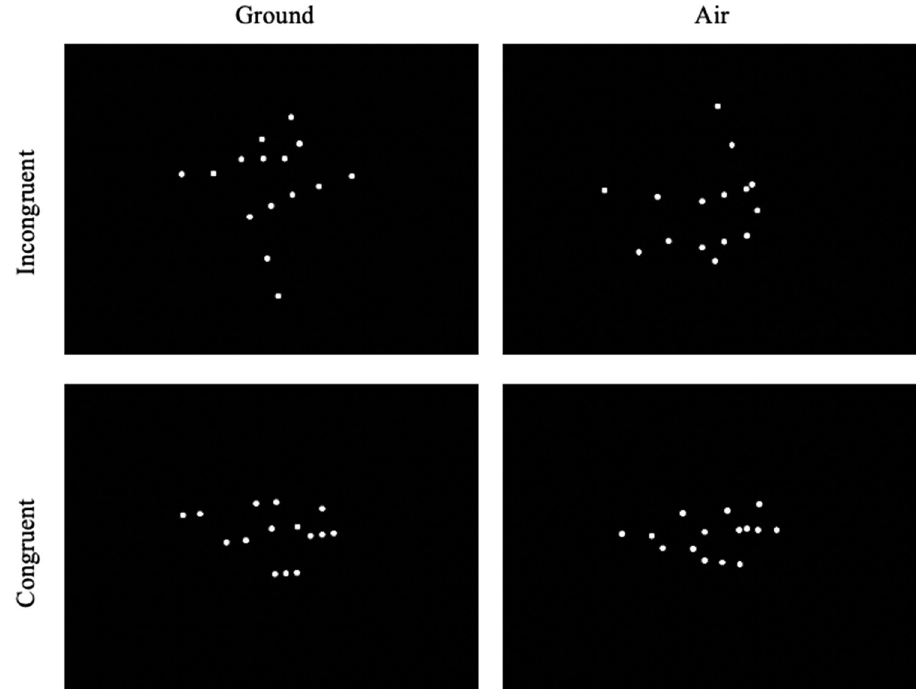
Figure 1. Illustration of the movements of different congruency and recording types. For the incongruent movement pairs (top row), the original (i.e., uninverted) ground and air movements had identical forms but opposite orientations. For the congruent movement pairs (bottom row), the original ground and air movements had identical forms and orientations. See the video demo (https:// youtu. be/ 6vLQg Qpy- uc) for more